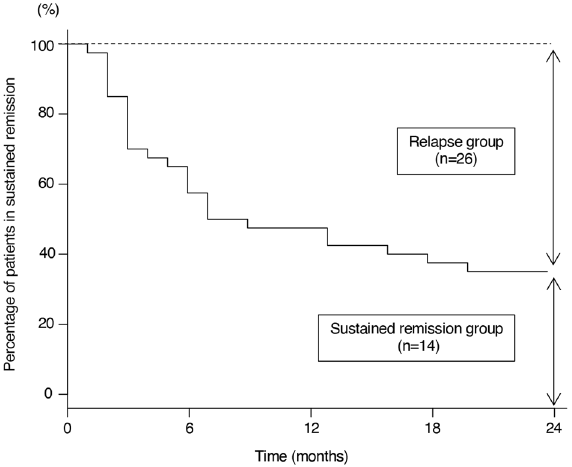
Figure 2. Kaplan–Meier curve showing percentage of patients on remission during 24 months of study span. The number of patients in remission decreased quickly during the first 6 months and the reduction rate became very slow thereafter. The image was created using EZR (ver. 1.52, https:// www. jichi. ac. jp/ saita ma- sct/ Saita maHP. files/ statm edEN. html).